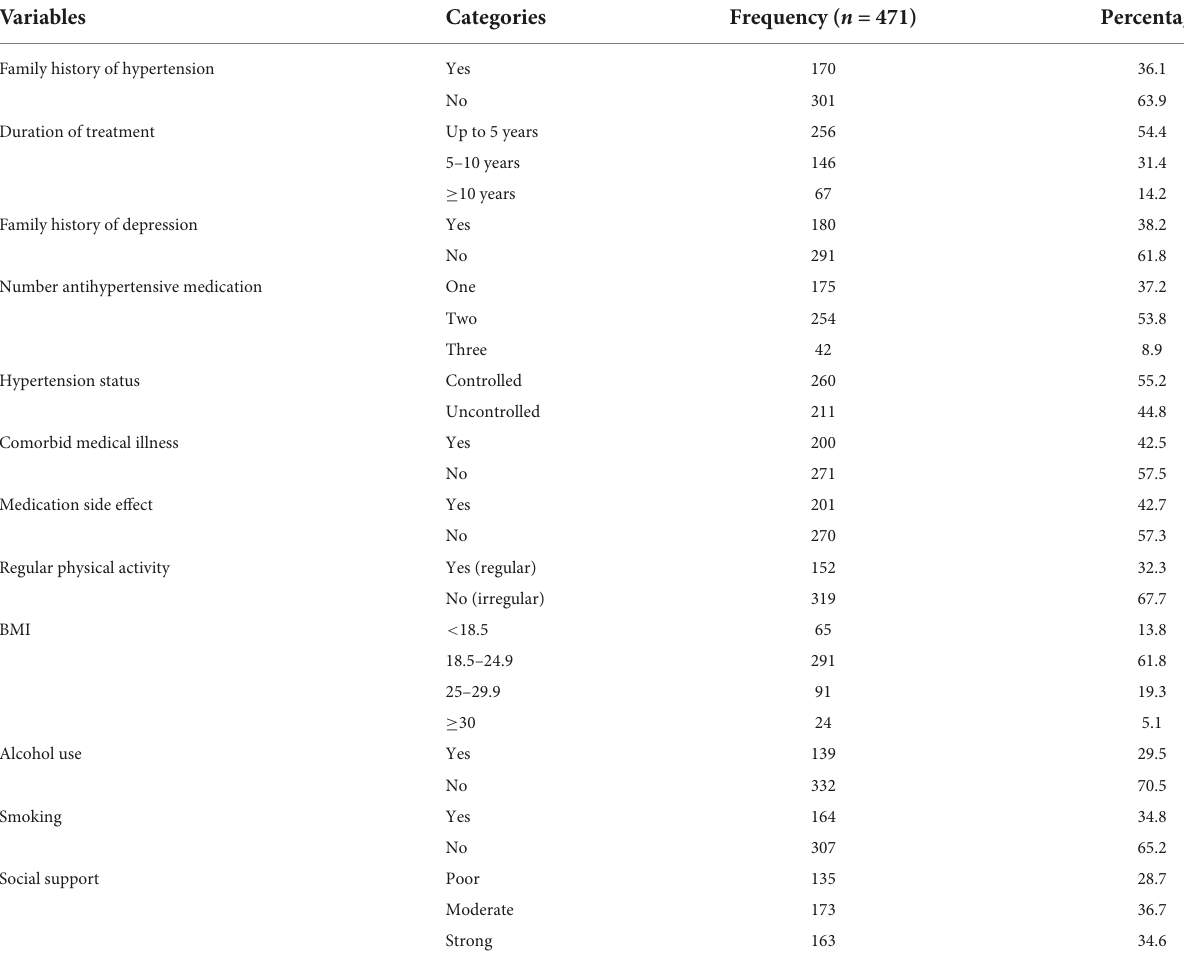
TABLE 2 Clinical, substance use, and psychosocial characteristics of people with hypertension on follow-up in Eastern Ethiopia ( n = 471).